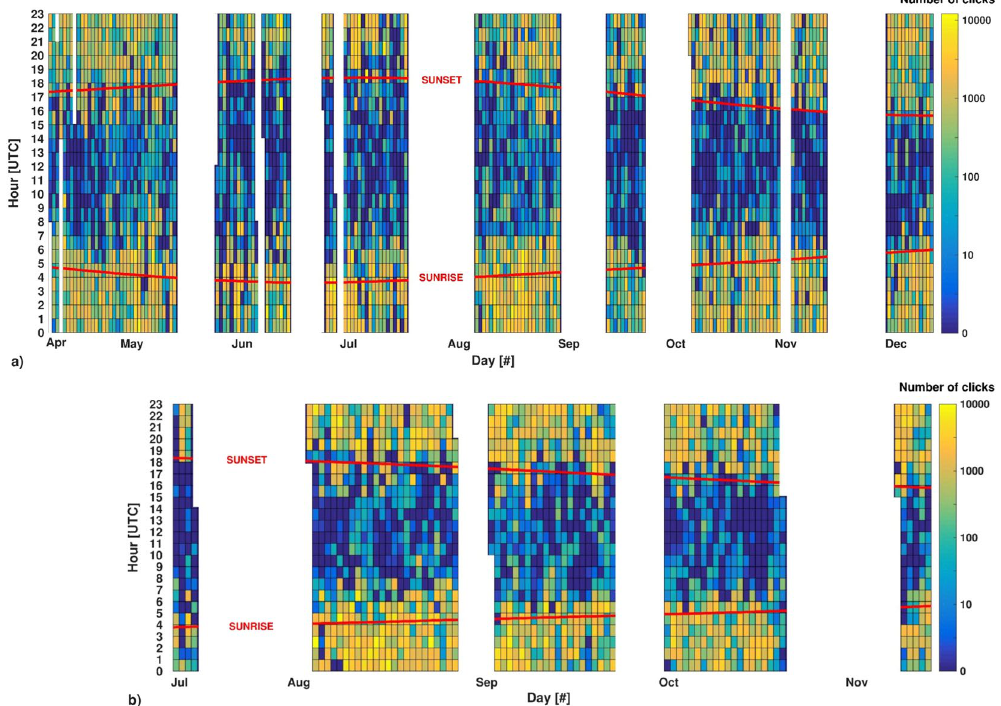
Figure 5. Influence of sunrise and sunset on biosonar activity of dolphins. Red lines indicate variation of sunrise and sunset timing through the months. ( a ) Number of clicks detected per hour during 2005; ( b ) Number of clicks detected per hour during 2006.